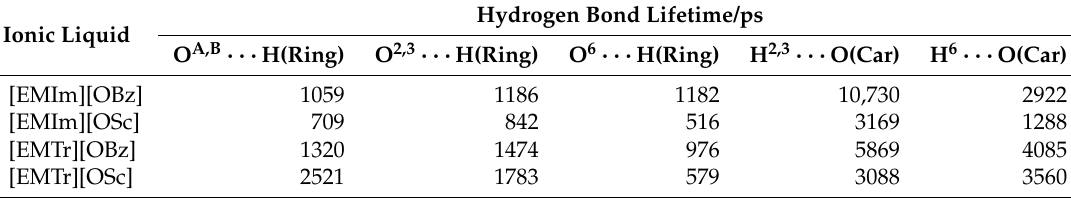
Table 5. Computed intermittent hydrogen bond lifetimes between cellulose and solvent. For atom labels, see Figure